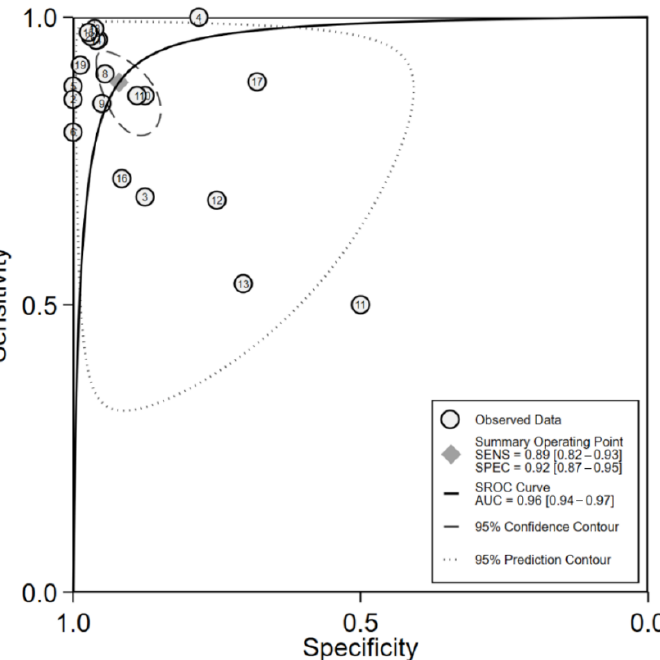
Figure 3. Summary receiver operating characteristics (SROC) curves of eligible studies. The dashed line indicates the 95% confidence region, and the dotted line indicates the 95% prediction region.